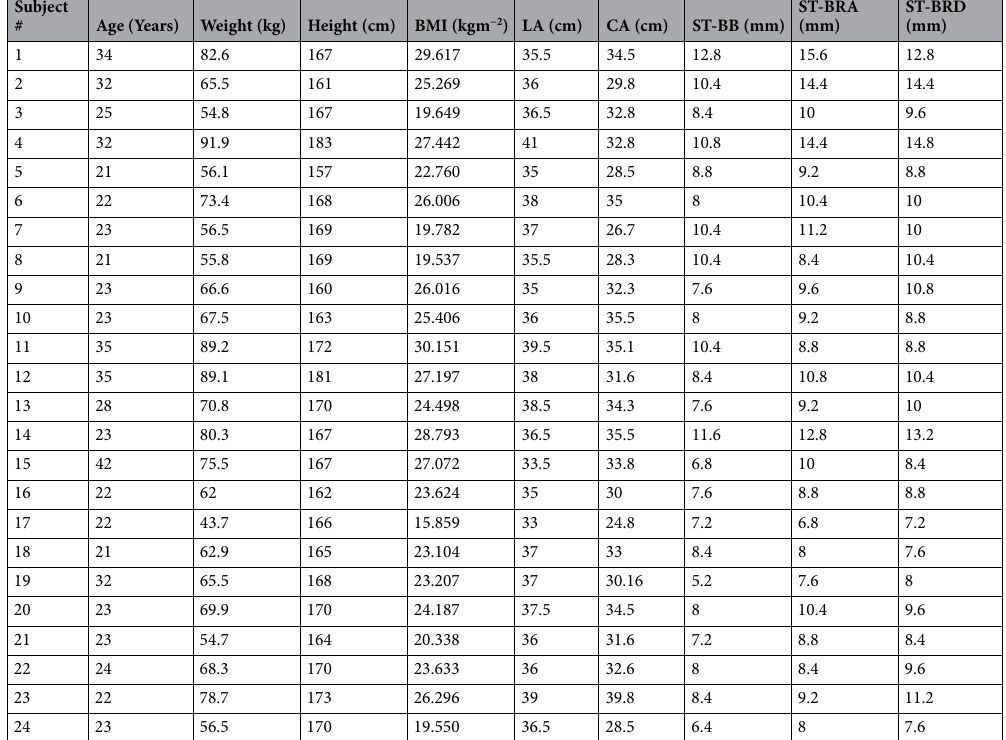
Table 1. Anthropometric details of subjects. BMI, body mass index; LA, length of arm; CA, circumfernec of arm; ST, skin fold thickness; BB, biceps brachi; BRA, brachialis; BRD,